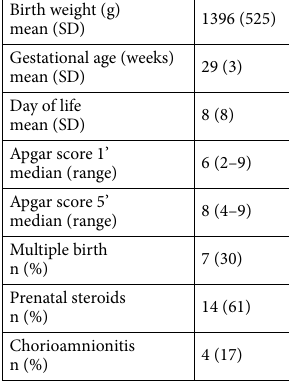
Table 1. Patients’ characteristics.